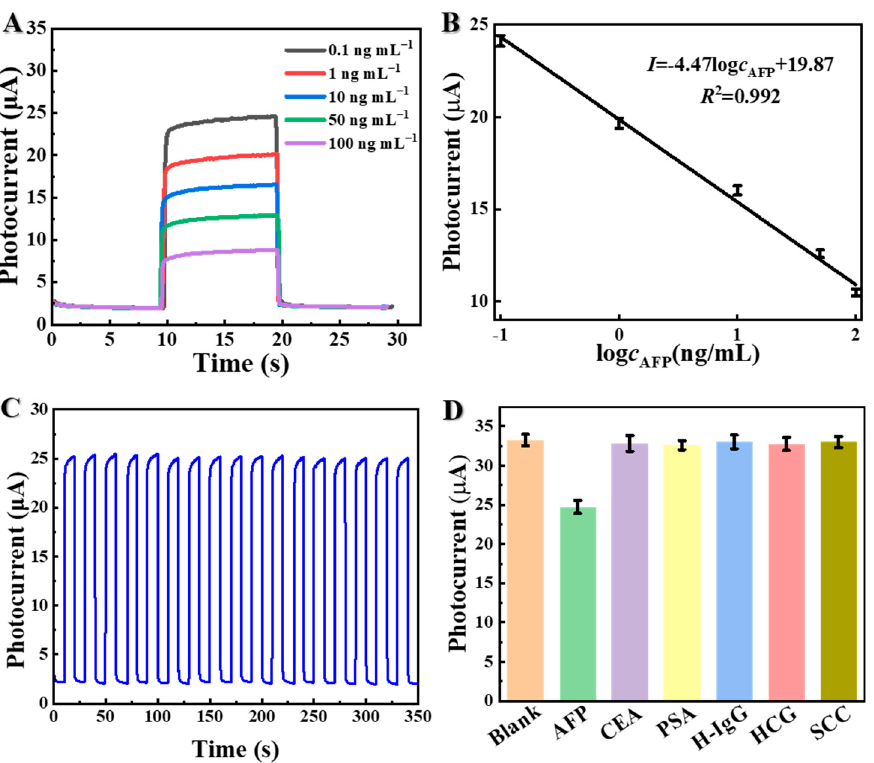
Figure 6. ( A ) PEC signals of different concentrations of AFP. ( B ) Calibration curve of photocurrent vs logarithm of AFP concentration. ( C ) Stability of the PEC signals for 350 s ( c AFP = 0.1 ng mL − 1 ). ( D ) Selectivity of the proposed PEC assay of AFP ( c AFP = 0.1 ng mL − 1 ). Error bars reflect the standard deviation of the measured data of three parallel experiments. All PEC signals were performed in 0.1 M PBS (pH 6.6) containing 0.1 M AA, and the applied potential was set at 0.4 V. Table 1. Assay results of real human serum by proposed µ PAD. Serum